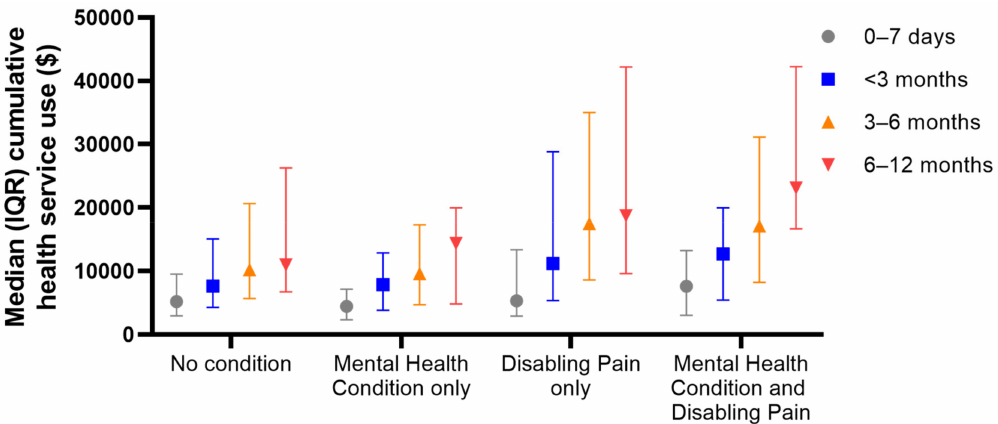
Figure 3. Median (IQR) cumulative health service use for people with neither condition, mental health condition only, disabling pain only or both mental health condition and disabling